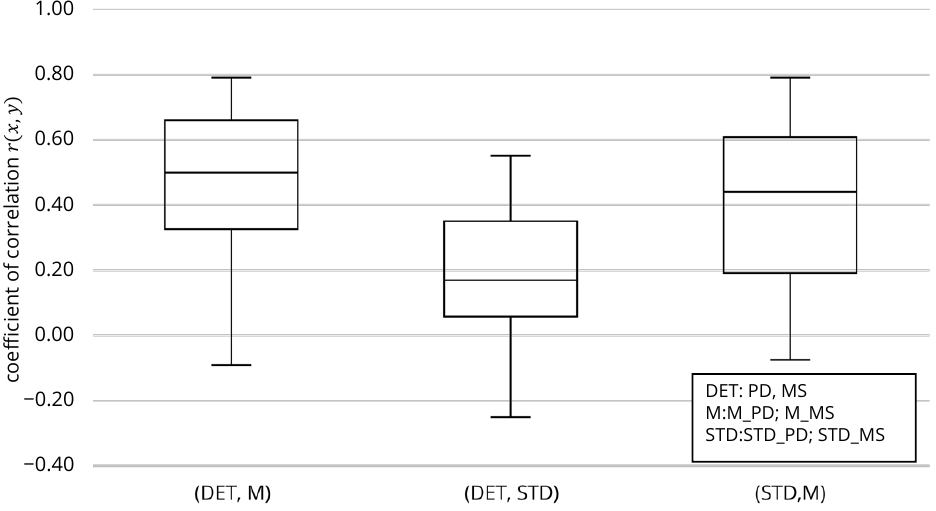
Figure 5. Boxplot correlation between the deterministic ( DET ) and stochastic ( STD , M )